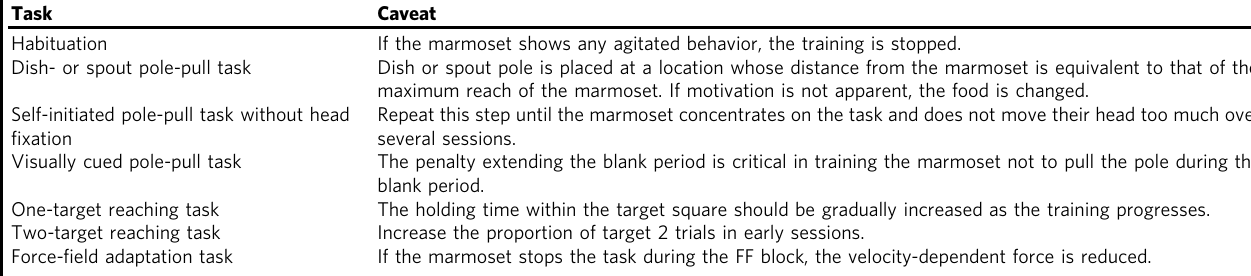
Table 1 A list of caveats for each step of the tasks Task Caveat Habituation If the marmoset shows any agitated behavior, the training is stopped. Dish- or spout pole-pull task Dish or spout pole is placed at a location whose distance from the marmoset is equivalent to that of the maximum reach of the marmoset. If motivation is not apparent, the food is changed. Self-initiated pole-pull task without head fi xation Visually cued pole-pull task One-target reaching